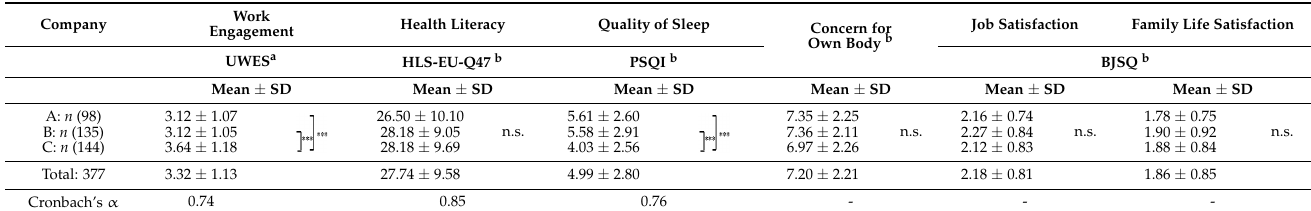
Table 2. The score of participant scales and its comparison between three companies.